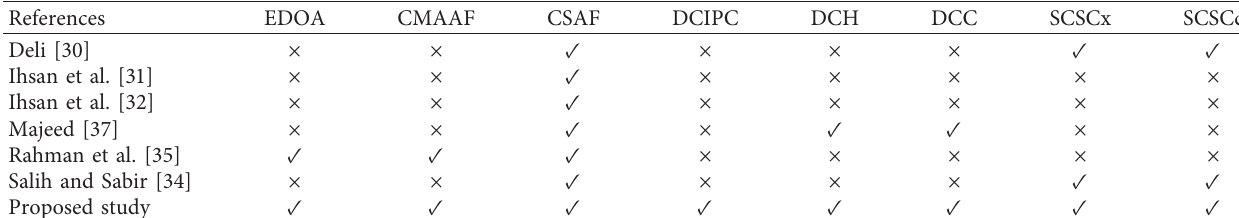
Table 1: Comparison of the proposed approach with existing relevant